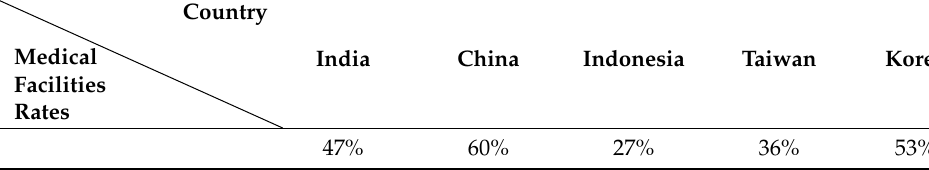
Table 3. The amount of medical equipment.